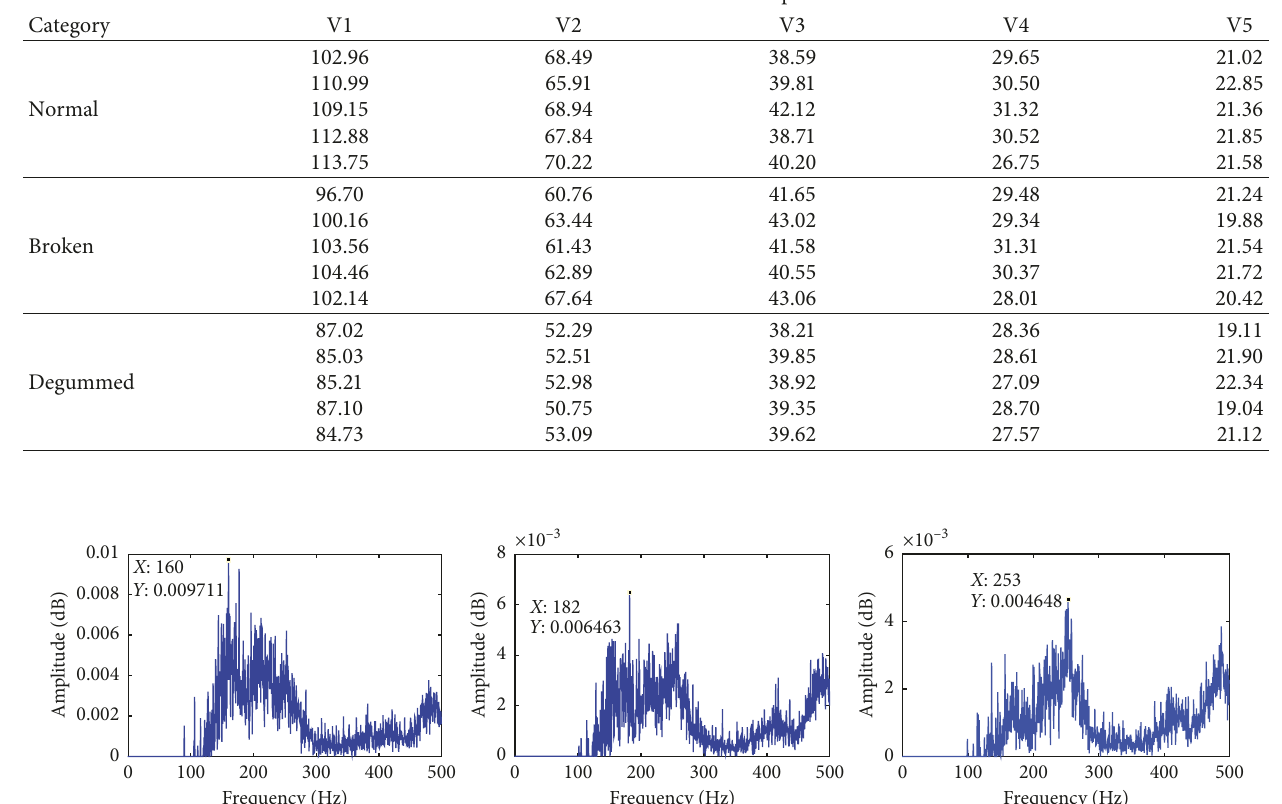
Table 3: SVD values of IMF components of three kinds of piezoelectric chip signals under noise signals. SVD values of the first five IMF components